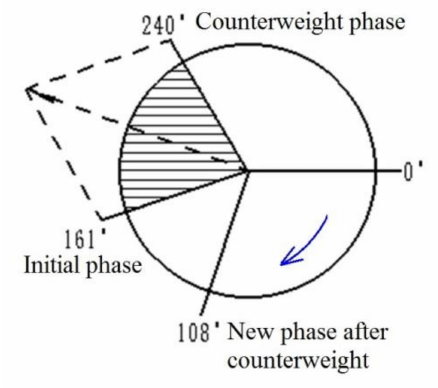
Figure 8. Unbalanced phase relationship diagram.